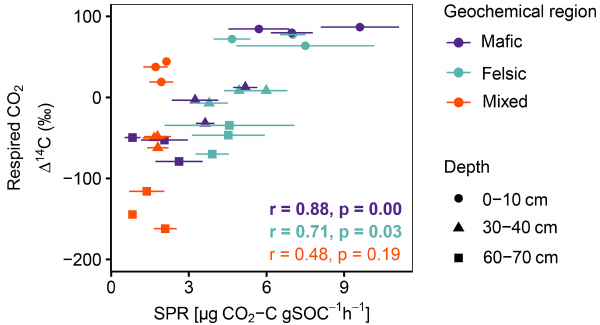
Figure A2. Pearson correlation between (cid:49) 14 C of respired CO 2 and SPR for non-valley positions. Data displayed are averages plus the standard error of three field replicates ( n = 85). p values in bold indicate significant results at p < 0.05.